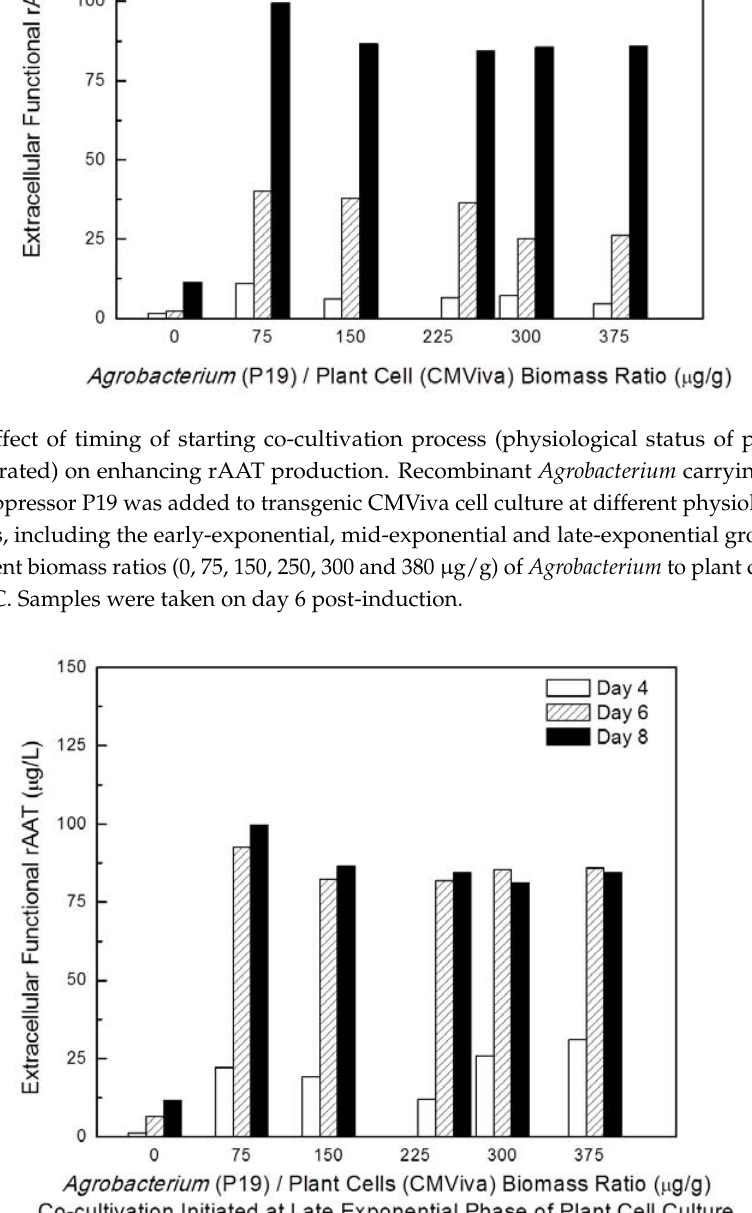
Figure 5. Time course of functional rAAT production in transgenic CMViva cells co-cultivated with recombinant Agrobacterium carrying P19. Co-cultivation was initiated in the late exponential phase of plant cell culture, with a variety of biomass ratio (0, 75, 150, 250, 300 and 380 µ g/g) of Agrobacterium to plant cells in shake flasks at 20 °C. Samples were taken on days 4, 6 and 8 post ‐ induction.